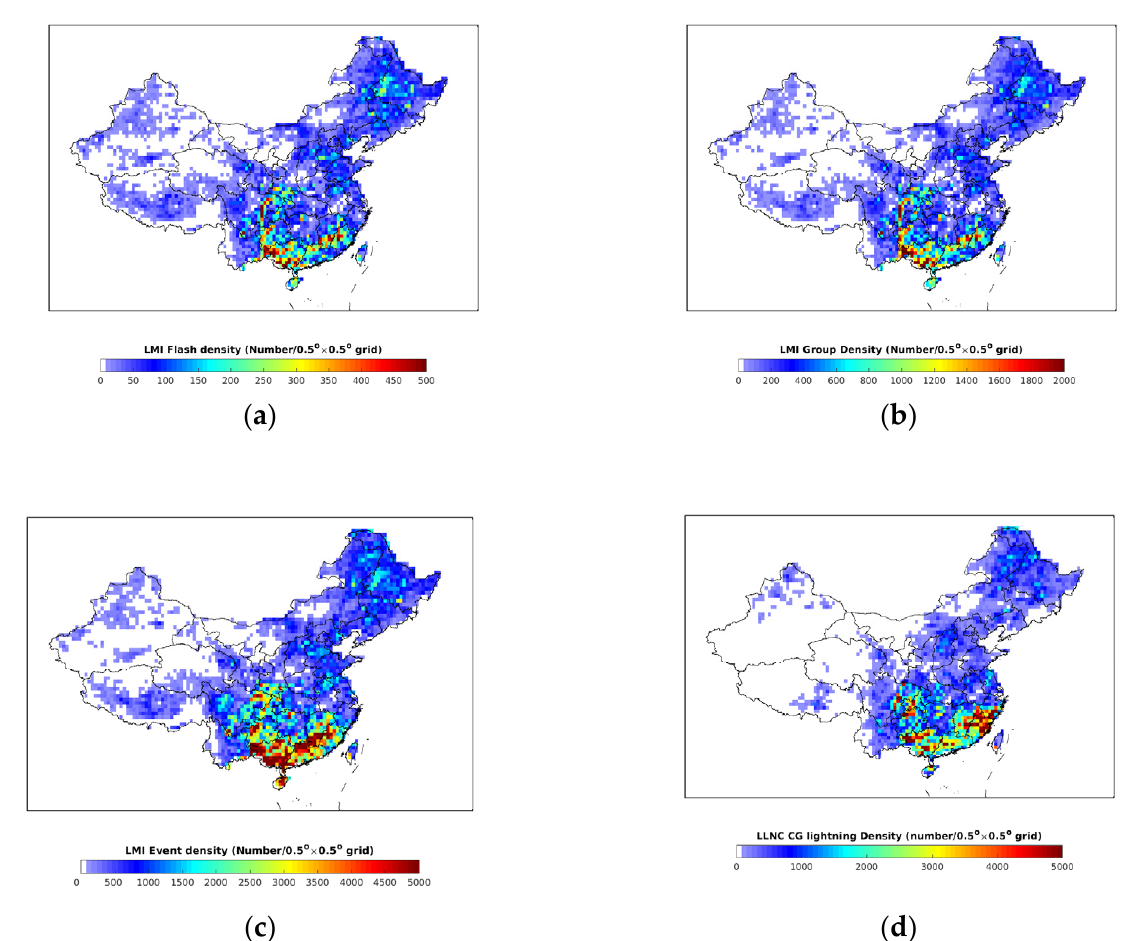
Figure 2. Spatial distribution of lightning density observed by FY-4A LMI and LLN Cin July 2019. ( a ) LMI Flash, ( b ) LMI Group, ( c ) LMI Event, and ( d ) LLNC CG Event.